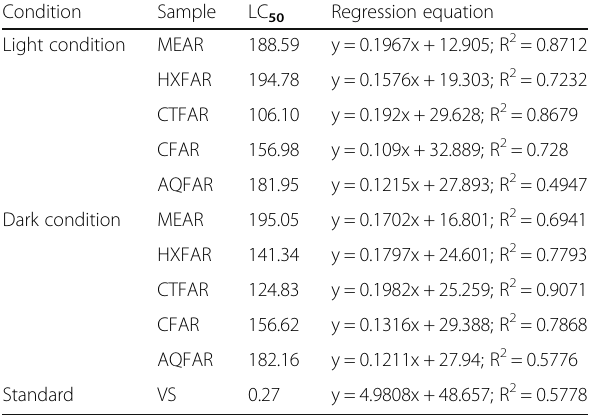
Table 3 LC 50 values of methanolic extract of Albizia richardiana at light and dark condition with regression equation as well as standard vincristine